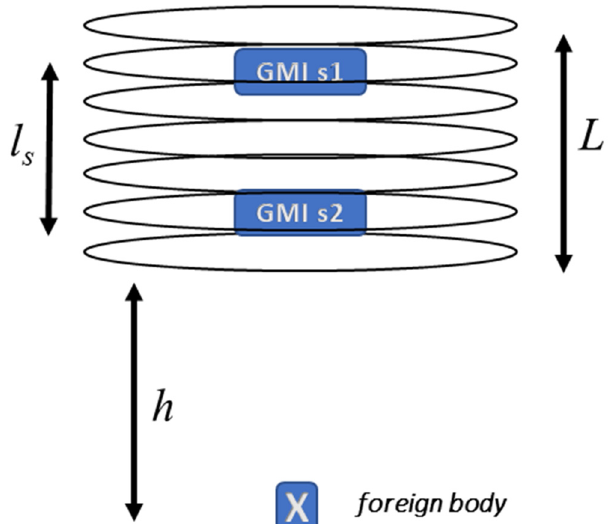
Fig. 1. Solenoid representation with two GMI sensors in gradiometric con fi guration and a foreign body “ x ” [36 – 38]. h is the distance between the bottom of the solenoid and the foreign object; L is the length of the solenoid; and l s is the distance between the centers of the two GMI sensors